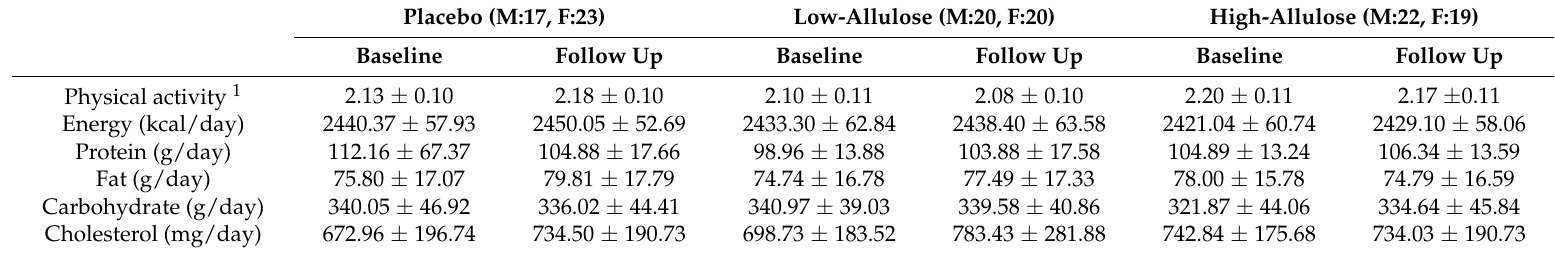
Cholesterol (mg/day) 672.96 ±